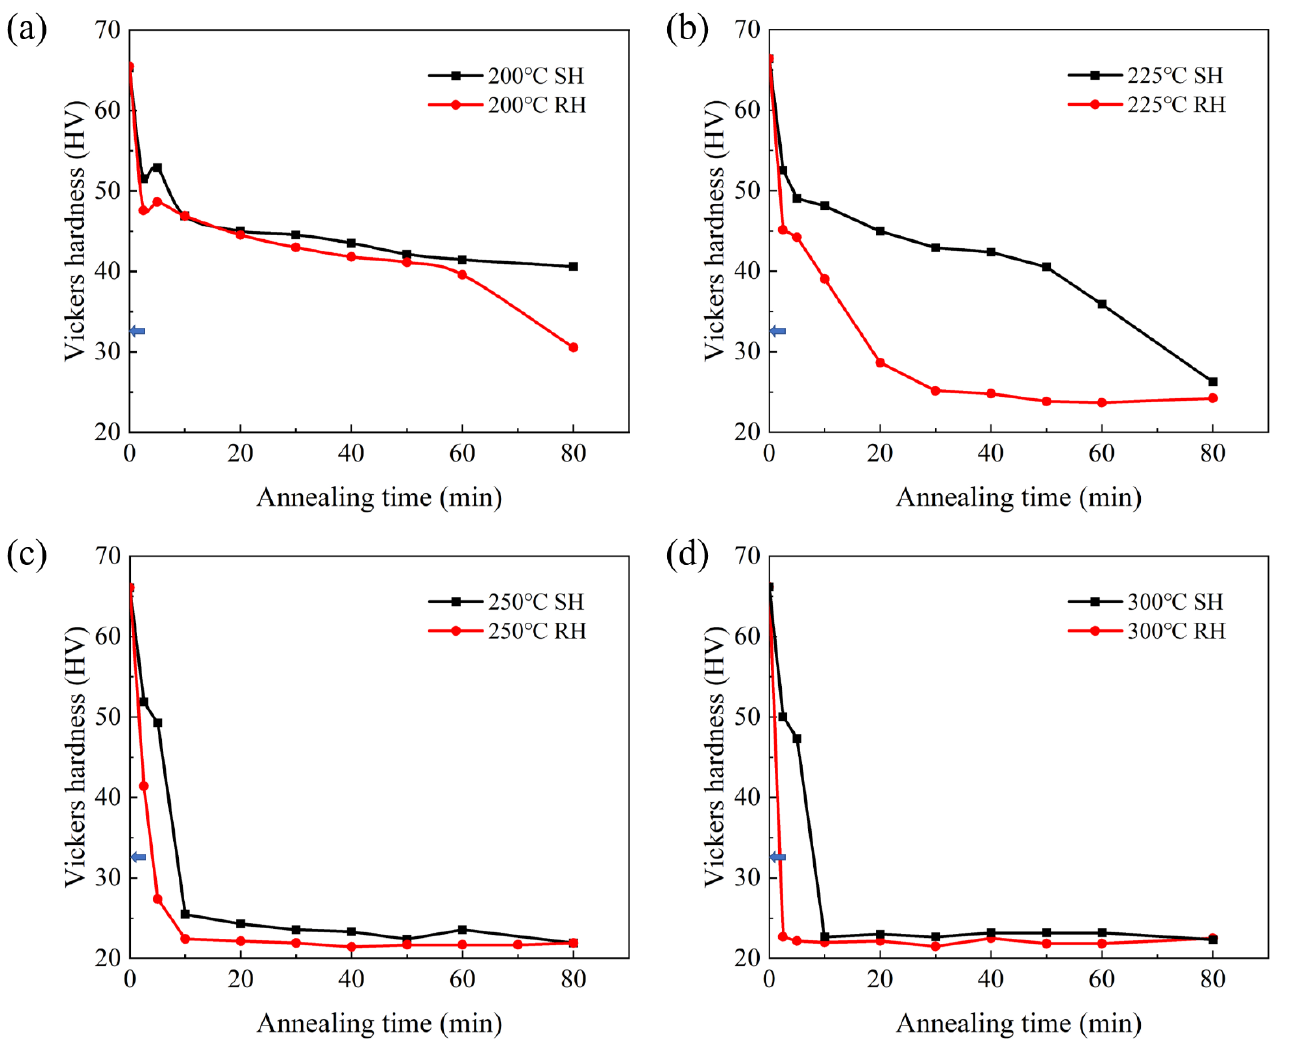
Figure 7. Hardness curves of cold-rolled Al-0.5%Cu annealed in different heating rate and heated to different target temperatures for different holding time, the arrows point to the original hardness: ( a ) 200 °C; ( b ) 225 °C; ( c ) 250 °C; ( d ) 300 °C.